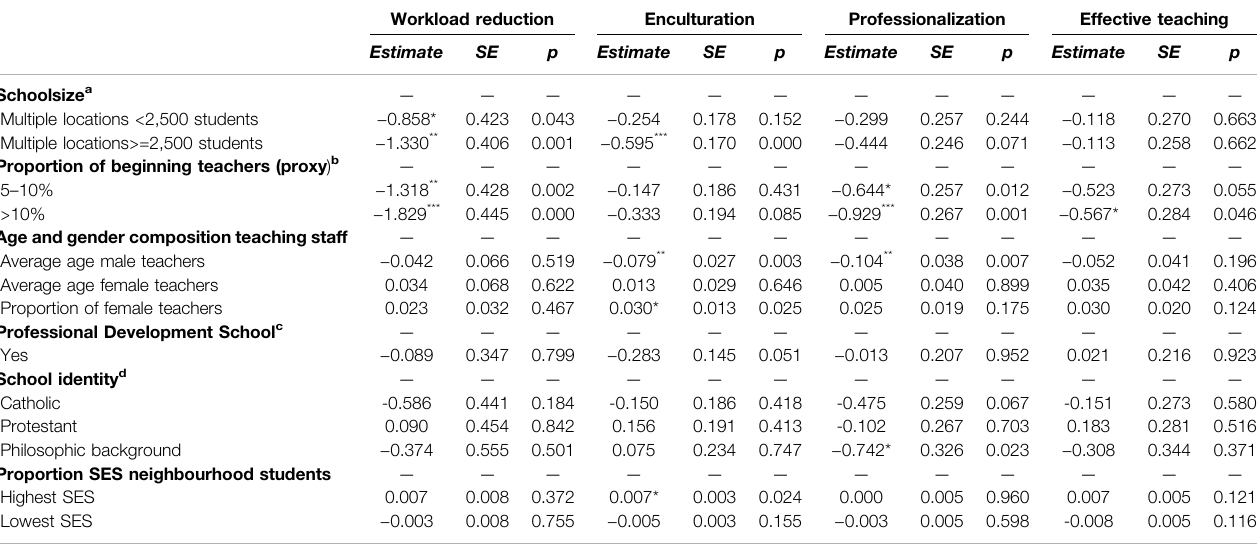
TABLE 2 | Binary models: relation reported support activities by BTs and school characteristics, four induction elements, full sample (N (cid:1) 195). Workload